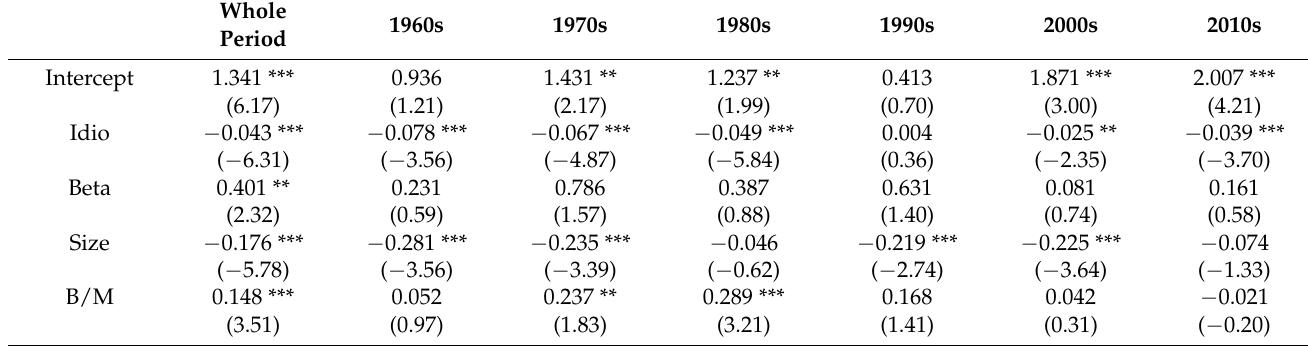
Table A3. This table reports the regression results of robustness tests when idiosyncratic risk is estimated by Fama and French (2015) five factor model. It reports the results of the firm-level Fama and MacBeth (1973) regressions of monthly stock returns on idiosyncratic risk for the period of July 1963 to December 2019. A stock should have at least 15 daily returns in a month to be included in the risk estimation. Stock-level market beta is estimated from 60-month rollover regressions. ME Size and B/M are size and book-to-market ratio in Fama and French (1992). Momentum is the compound gross return from month (t − 7) to (t − 2). TURN and CVTURN are the average volume turnover and coefficient of variance of TURN calculated over the past 36 months in Chordia et al. (2001). The idiosyncratic risk (Idio) is the standard deviation of regression residuals of daily stock returns in month t − 1. The Newey–West adjusted t-value is reported in parentheses. To avoid the effect of possibly spurious outliers, all explanatory variables below 0.1 (above 99.9) percentile are set equal to 0.1 (99.9) percentile. *, ** and *** denote the statistical significance level at 10%, 5% and 1%,